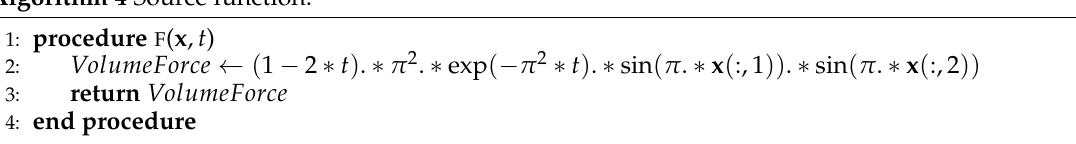
Algorithm 4 Source function.